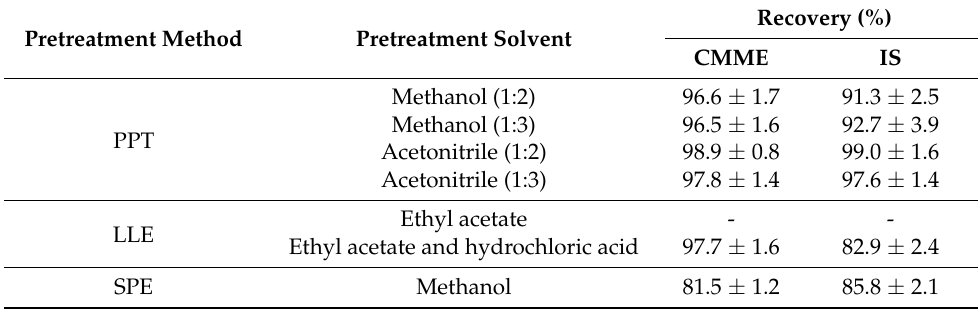
Table 1. Extraction recovery using different sample pretreatment methods of PPT, LLE and SPE. Pretreatment Method